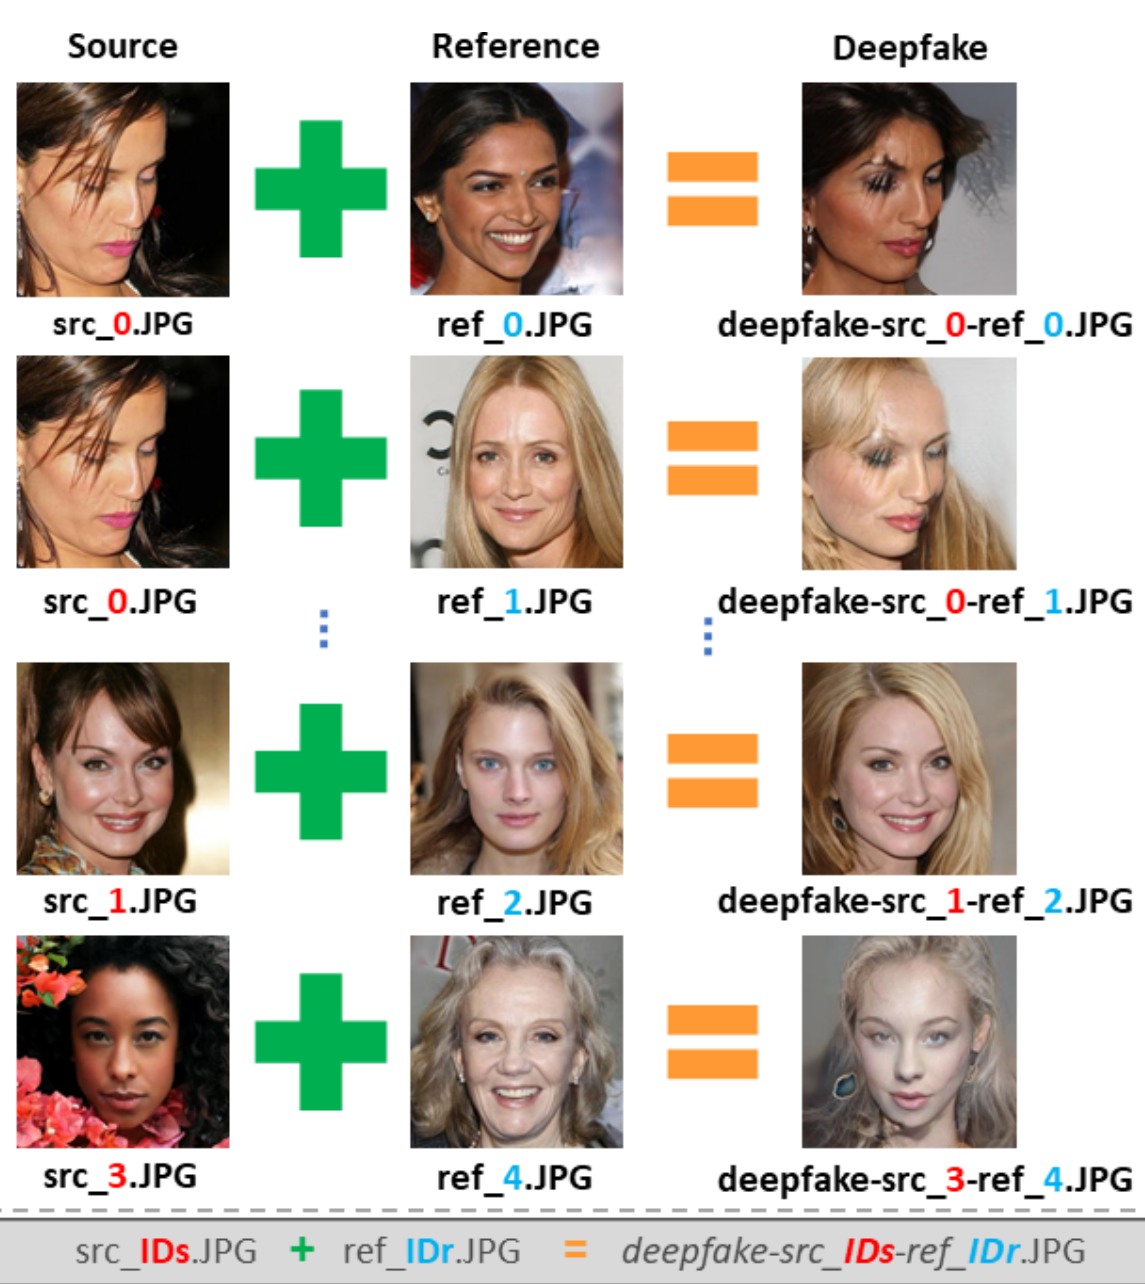
Figure 5. Name structure of source images, reference images and Deepfake